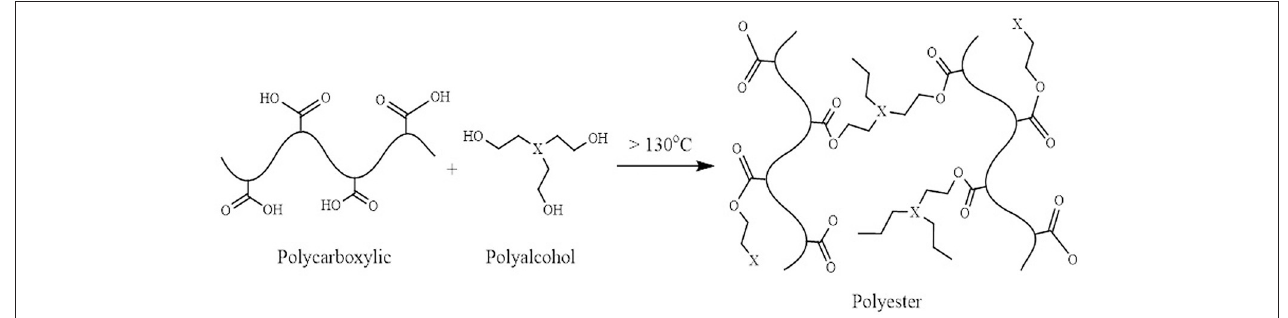
FIGURE 1 | Crosslinking reaction of Acrodur ® resin (Islam and Miao, 2013).